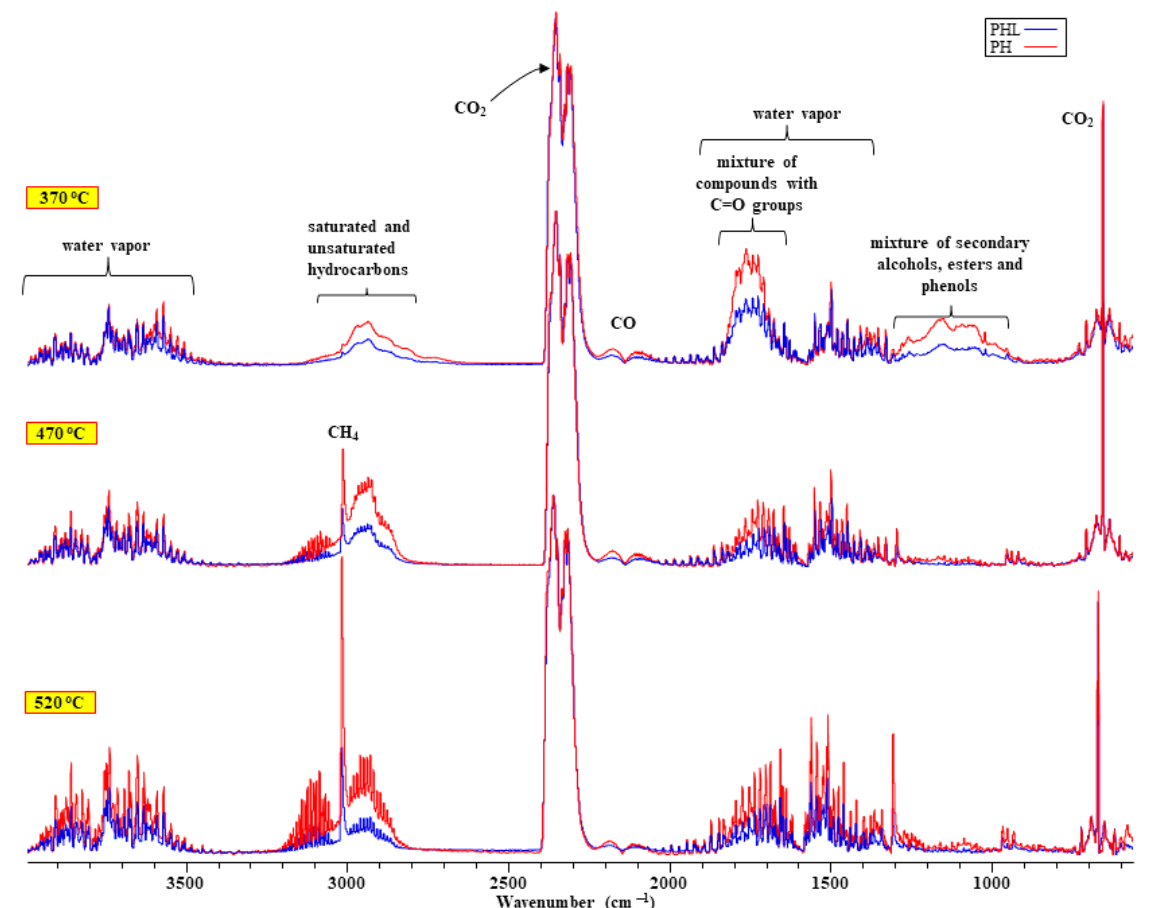
Figure 2. The volatile products of pyrolysis of PH samples in loose and densified forms.